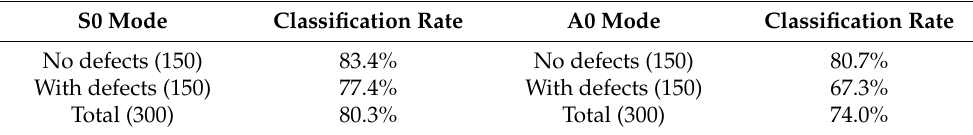
Table 2. Average classification rates for defects by LDA in S0 and A0 modes.